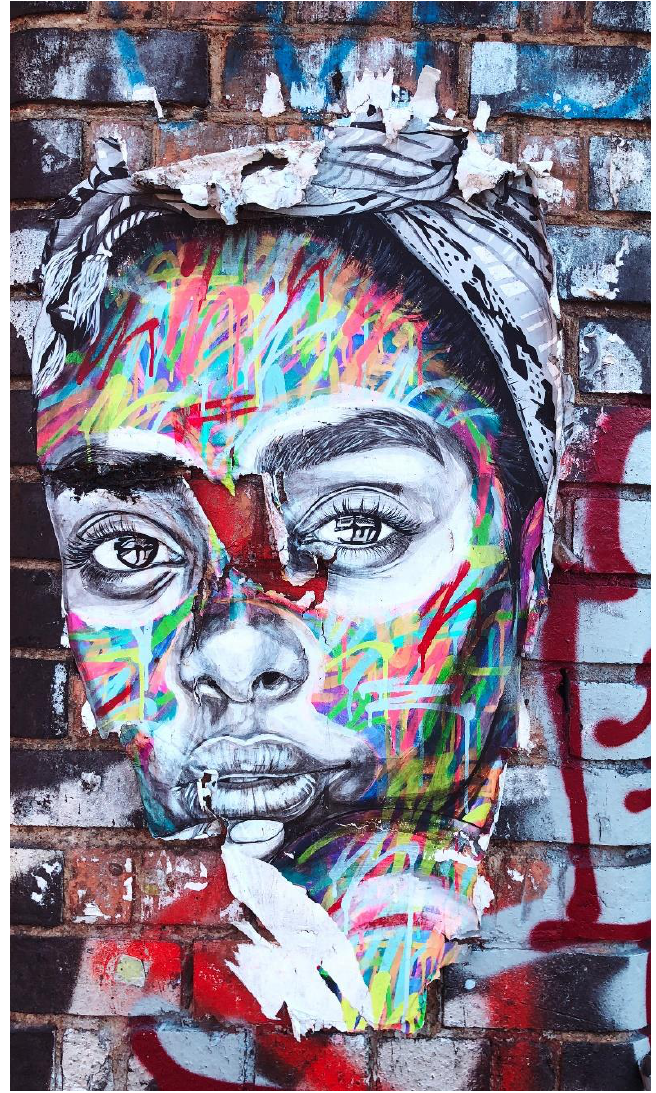
Figure 2: Banner image for Law, Technology and Humans - photograph by Jon